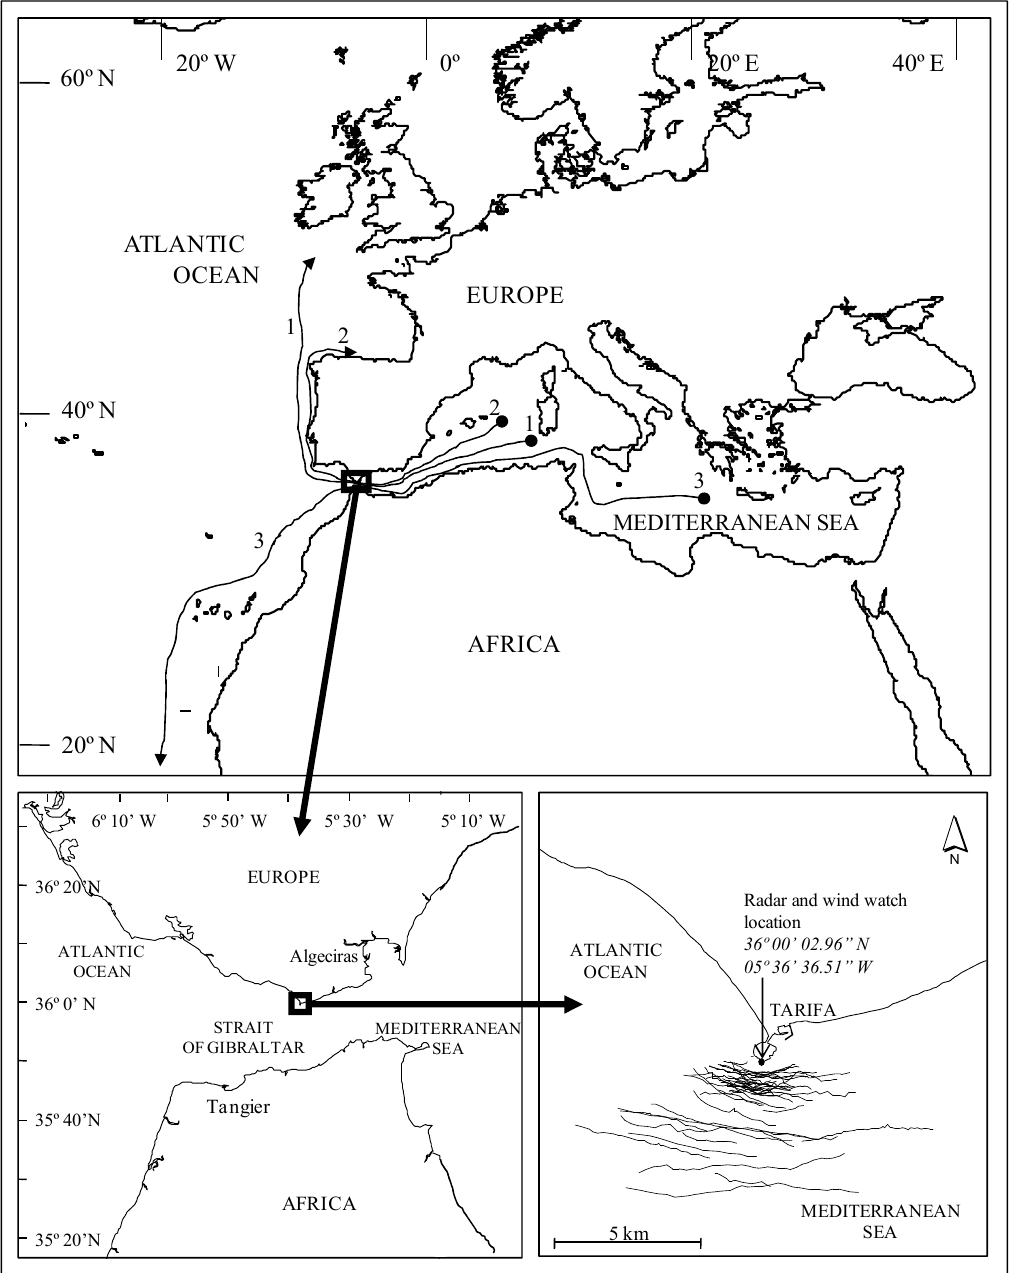
Figure 1. Migration routes of seabirds crossing the Strait of Gibraltar (birds return along the same routes). Line 1: main prenuptial migration route of auks and Gannet, which pass the Strait of Gibraltar mainly between mid-February to mid-April towards the northern east Atlantic where they breed. They come back to their wintering grounds in the Mediterranean mainly between mid-October to mid-November. Line 2: main postbreeding migration route of Balearic shearwater to the Atlantic Ocean from mid-May to mid-July. This species breeds in the western Mediterranean, where they return mainly between mid-October to mid-November. Line 3: main postbreeding migration route of Cory’s shearwater, mainly between mid-October to mid-November, to their wintering grounds in the sub-Atlantic ocean. This species breeds in the Mediterranean, where they return mainly between mid-February to mid-April (Arroyo et al. [28,29]). Insets: details of the African and Spanish coastline in the area of Tarifa. In the right panel, ten tracks per species (Cory’s shearwater, Balearic shearwater, Northern Gannet, and auks) flying towards the Atlantic are shown as examples of digitised radar